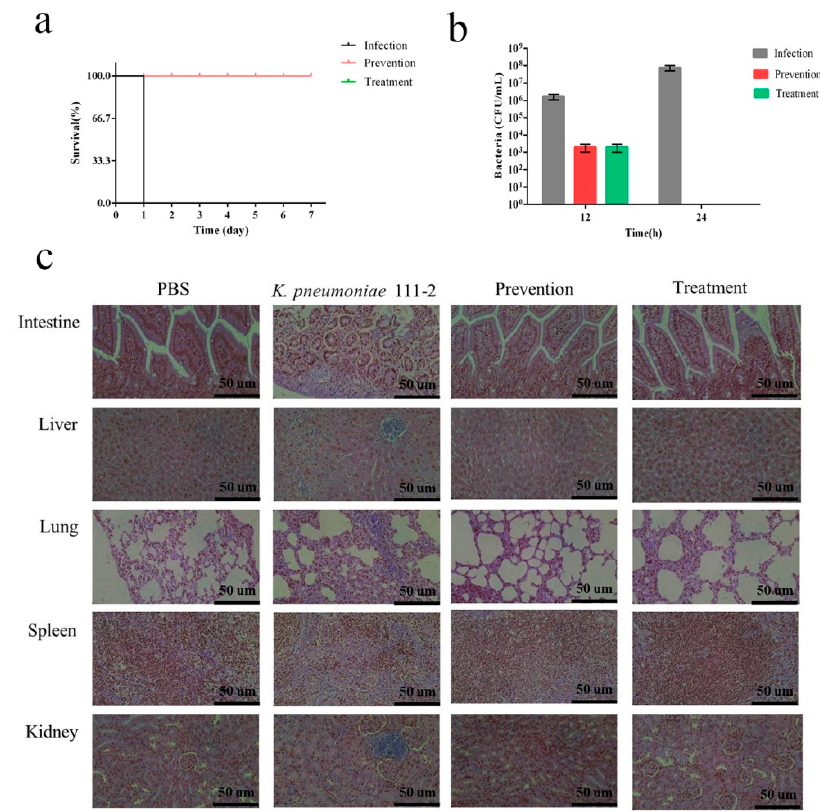
Figure 9. Protective and rescue effects of depolymerases Dep_ZX1 (50 µ g/mice) in mice challenged with K. pneumoniae 111-2. ( a ) Survival rate of mice. ( b ) Number of bacteria in the blood of mice. ( c ) Pathological slices of small intestines, livers, lungs, spleens and kidneys in mice, protective or rescued by Dep_ZX1 after 48 h.